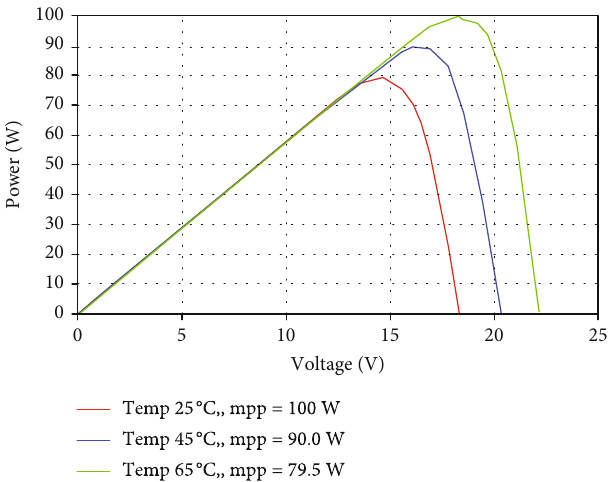
Figure 10: Temperature-dependent PV module power output [44].